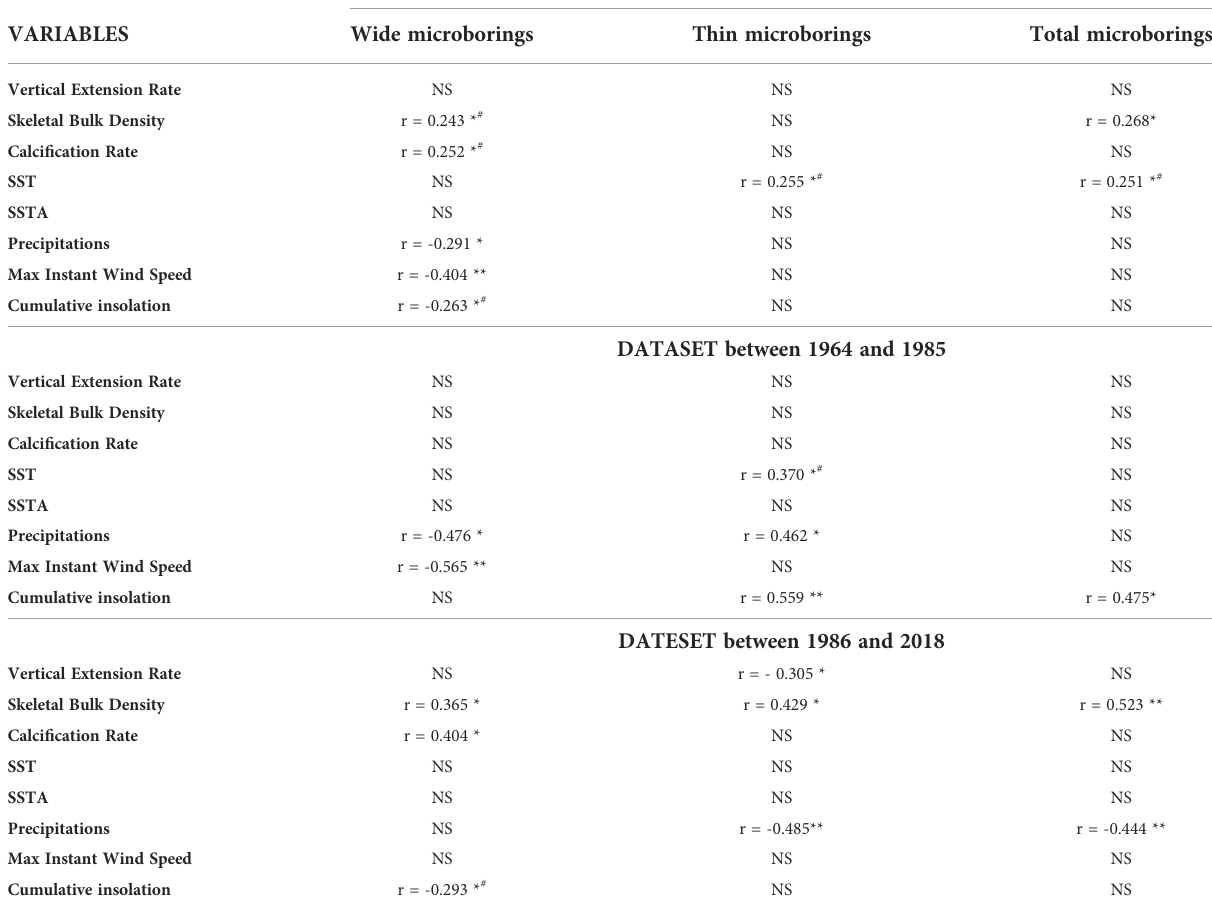
TABLE 4 Pearson ’ s correlations between the detrended abundance of microborers (wide, thin or total) and detrended environmental or coral growth variables over the last 50 years and per period before or after the breakpoint.